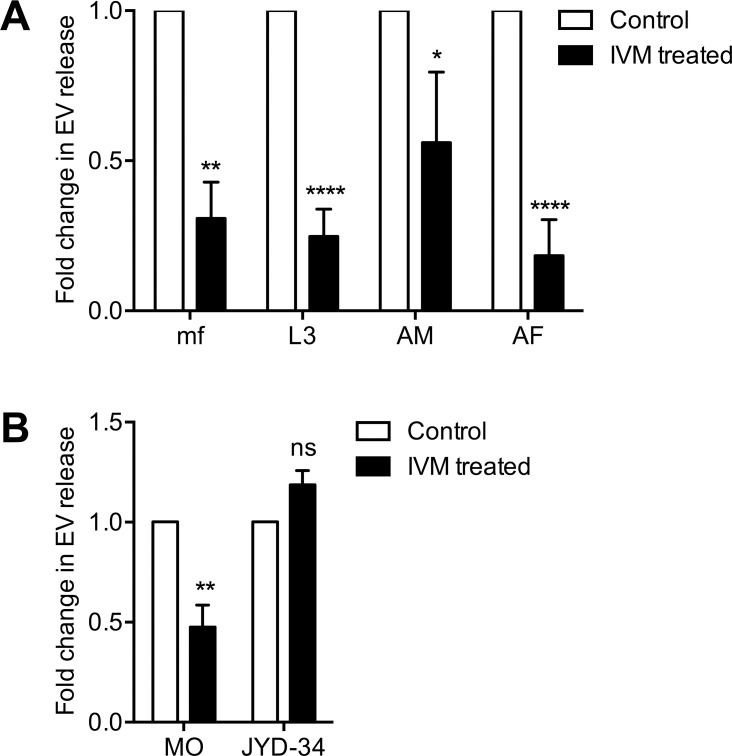
Ivermectin inhibits EV release from filarial nematodes.(A) 1 μM IVM reduces EV release by B. malayi in vitro. Microfilaria (mf), L3, adult male (AM) and female (AF) were incubated in RPMI containing IVM or vehicle control. Media was collected after 24 hr and EV isolated and quantified. N = 3 (minimum), mean ± SEM, *P<0.05, **P<0.01, ****P<0.0001. (B) 1 μM IVM reduces EV release in vitro by IVM susceptible Missouri strain (MO) D. immitis L3 but not IVM reduced susceptibility JYD-34 strain. N = 3 (minimum), mean ± SEM, **P<0.01, ns not significant.